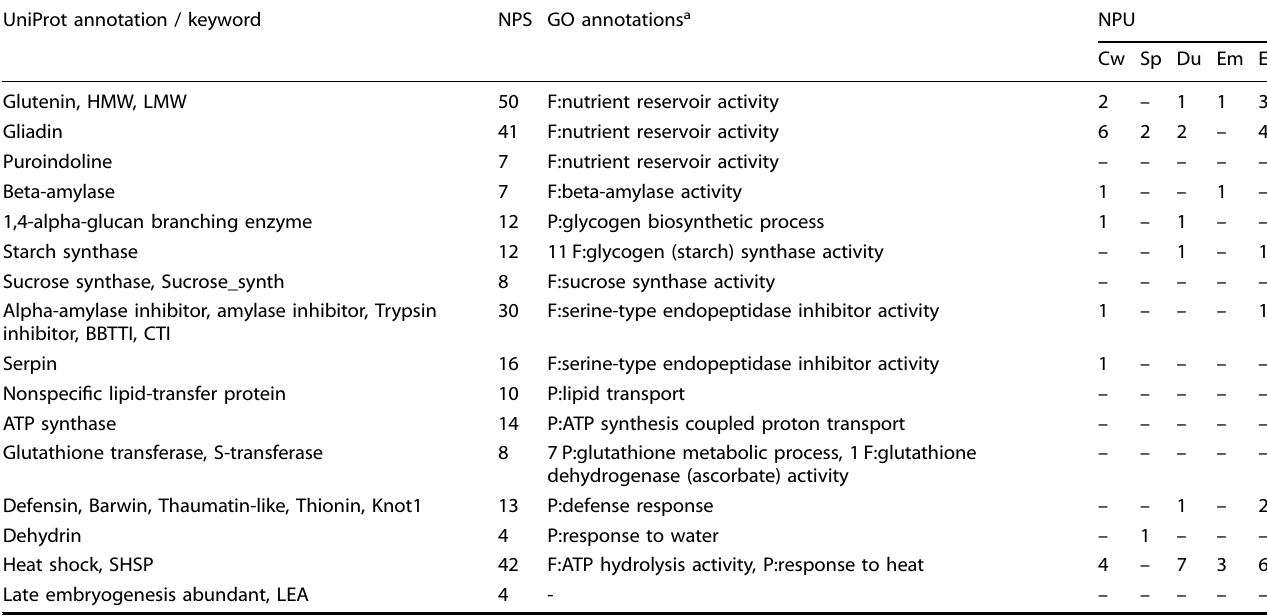
Table 2. Proteins with potentially important functions, which were signi fi cantly differently expressed (t-test, p value <0.05) between species. UniProt annotation /